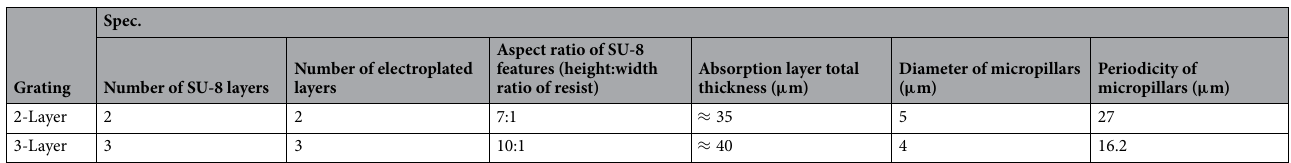
Table 1. Specifications of the prototype two-layer and three-layer